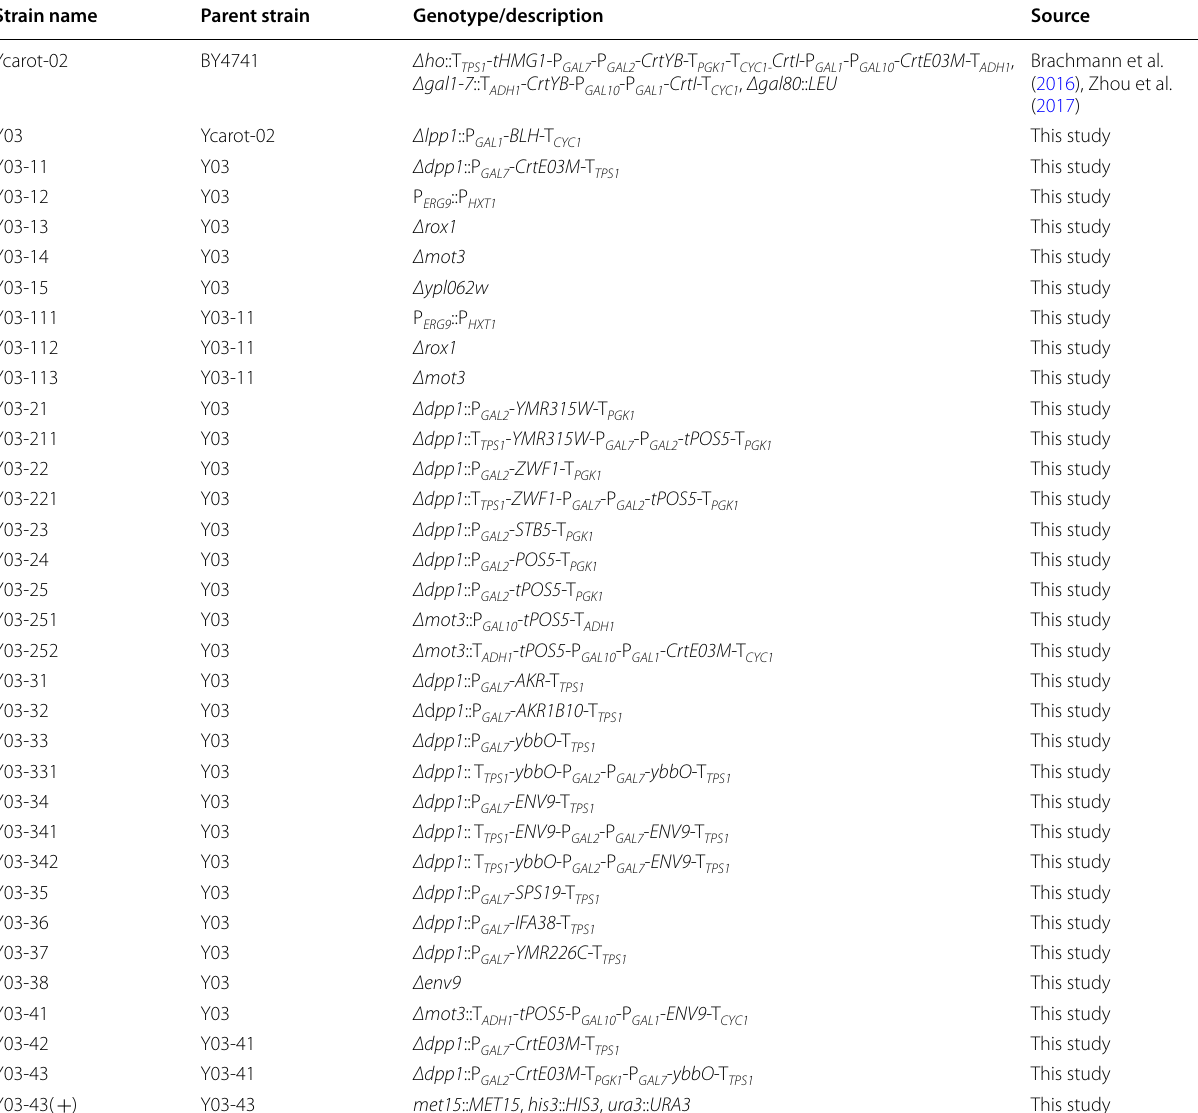
Table 2 S. cerevisiae strains used and constructed in this study Strain